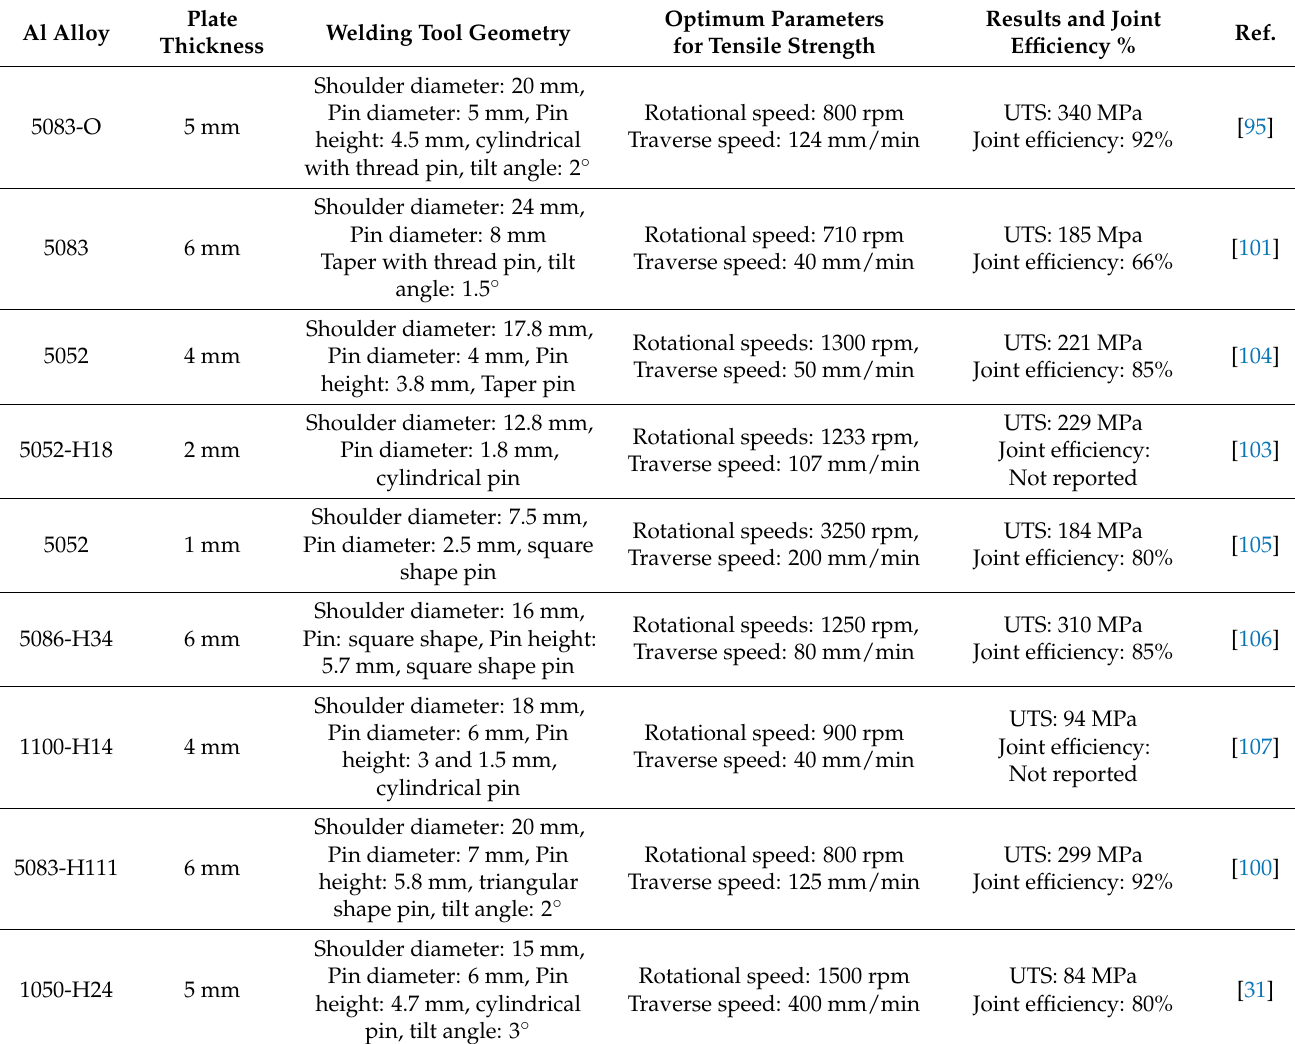
Table 2. A summary of selected optimization parameters reported achieving high tensile properties in FSW joints of non-heat-treated Al